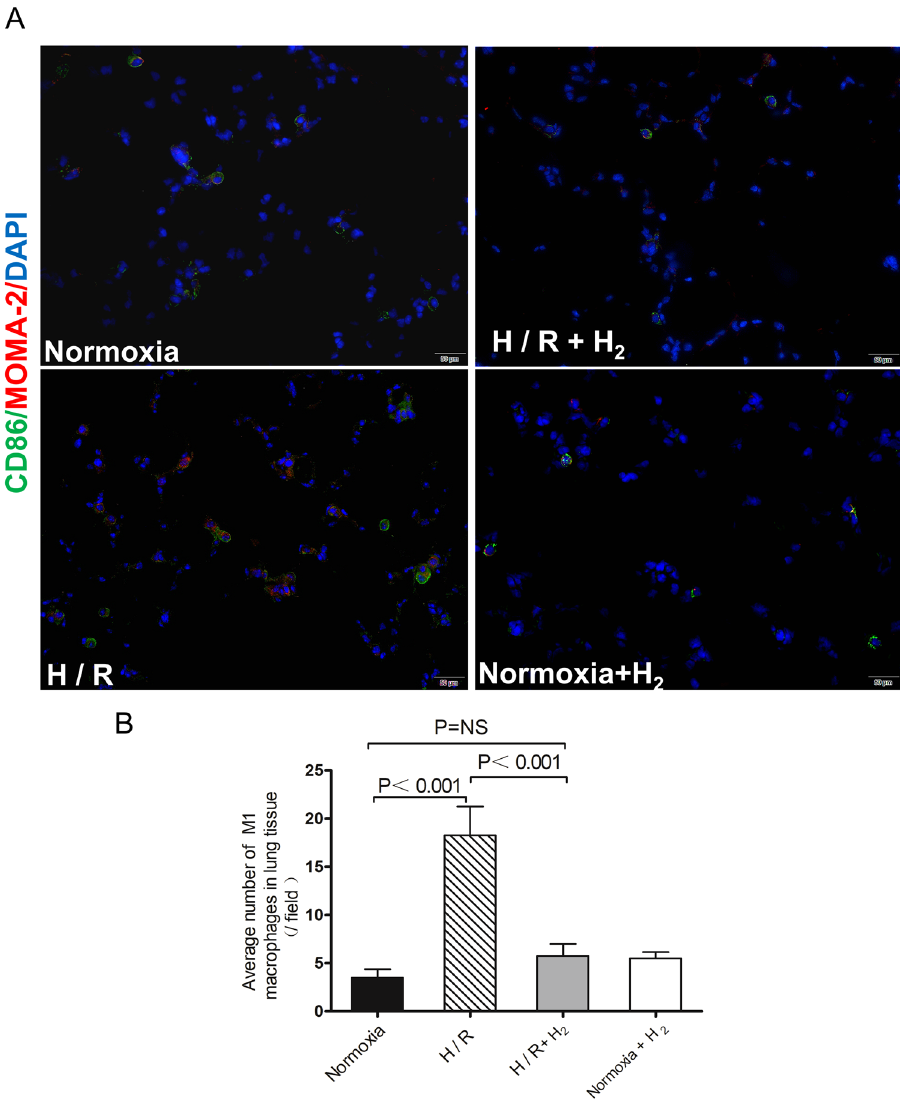
Figure 5. Staining ( A ) and quantitation ( B ) of M1 macrophages in the left lung. Animals were treated as described in Fig. 1 (n = 4 in each group). M1 macrophages were determined by immunofluorescence double staining with monocyte/macrophage marker (MOMA-2) and CD86. Sections were examined by confocal microscopy. The number of M1 macrophages in lung tissue was counted in one 200 × field for each animal. Scale bar, 50 μ m. Data shown are mean ± SEM. ns, not